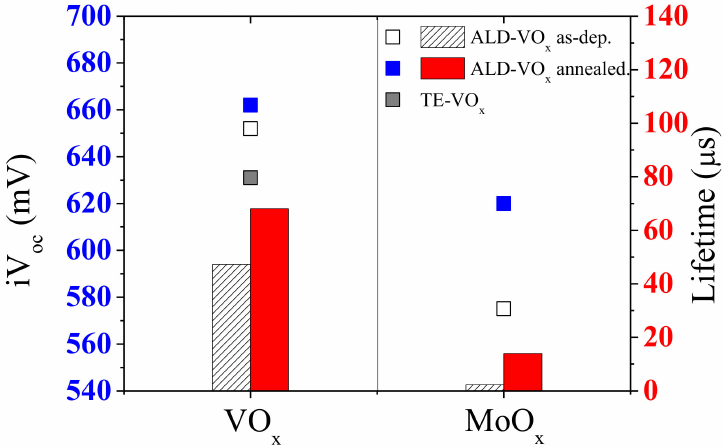
Figure 7. The comparison of lifetime and implied V OC for as-dep and annealed ALD-VO X and thermal evaporated VO X . Reproduced with permission from Reference